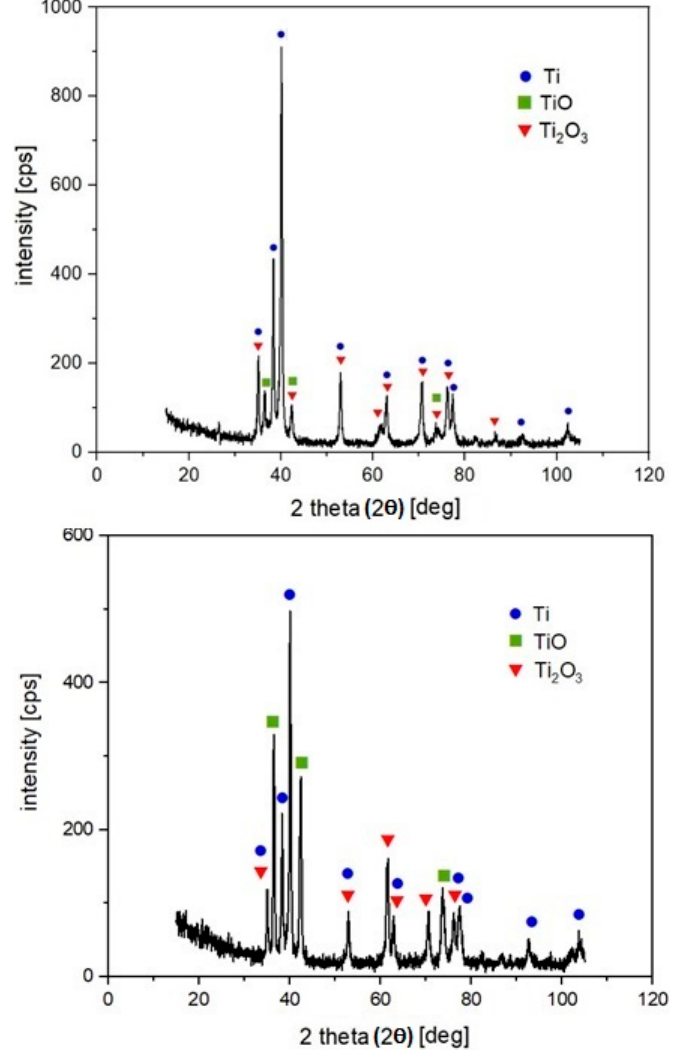
Figure 11. X-ray di ff raction patterns of machined surfaces S1 (up); S6 Figure 11. X-ray diffraction patterns of machined surfaces S1 (up); S6 (down).